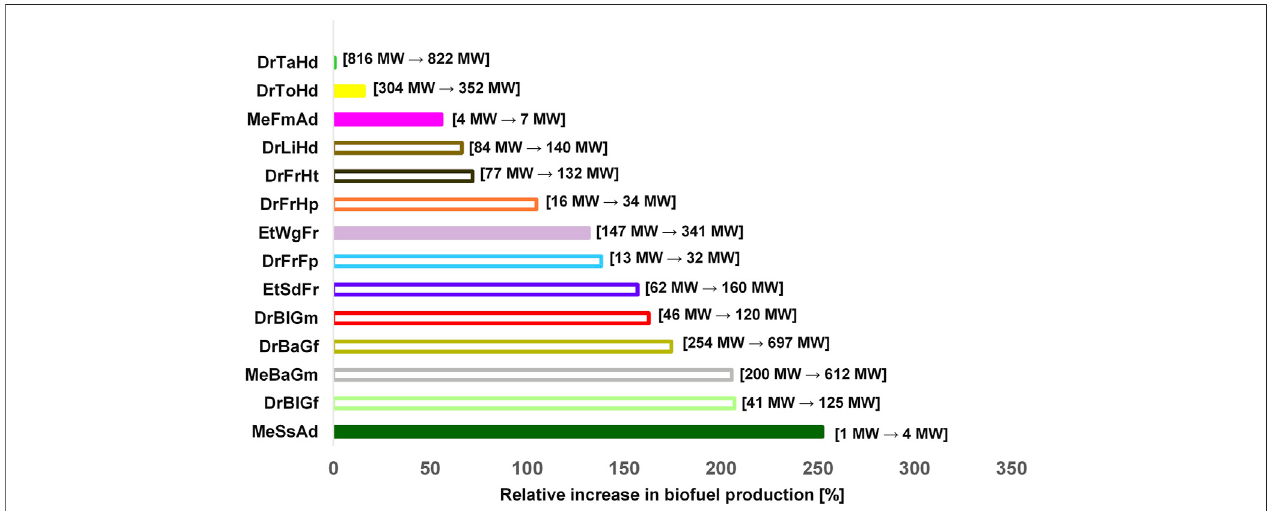
FIGURE 5 | Relative increase in biofuel production by rank order under the carbon capture and utilization (CCU) option. Absolute numbers are given in bold text. Empty bars represent emerging pathways and fi lled bars represent commercial pathways.